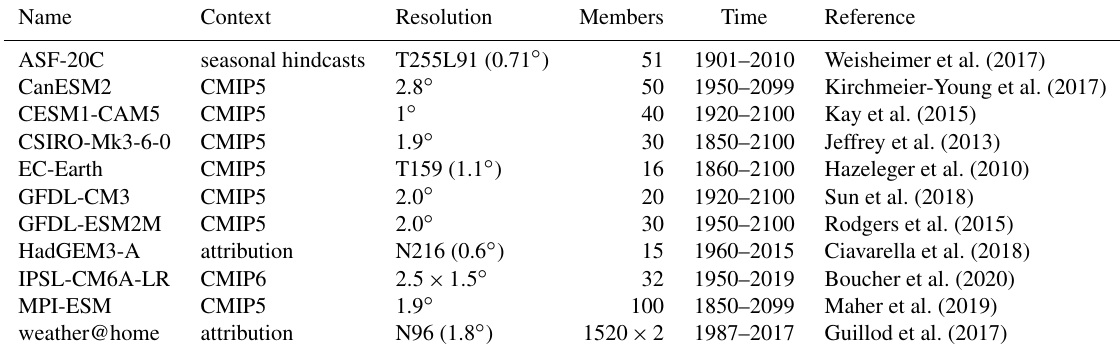
Table 1. List of climate model ensembles